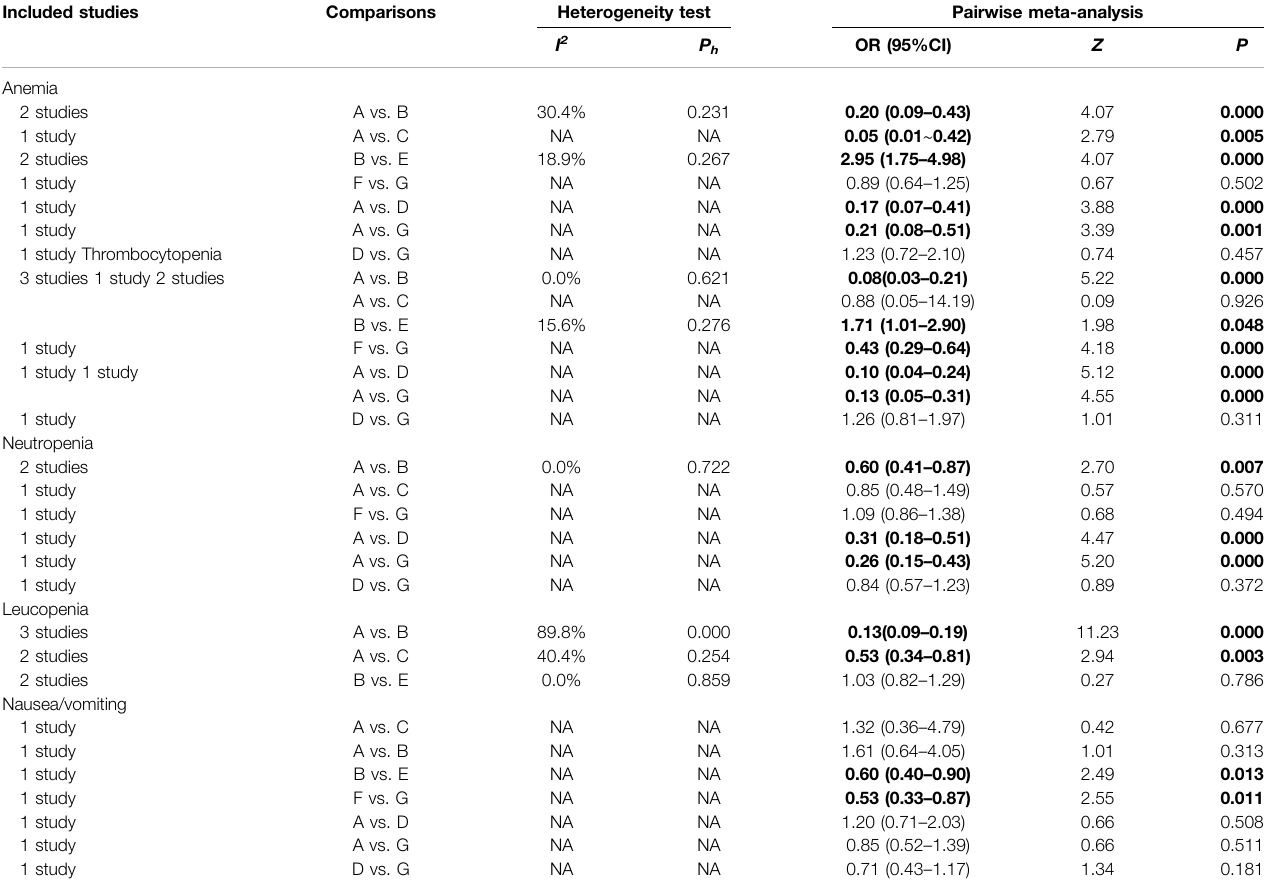
TABLE 2 | Estimated OR and 95%CI of pairwise meta-analysis for toxicity in Hodgkin